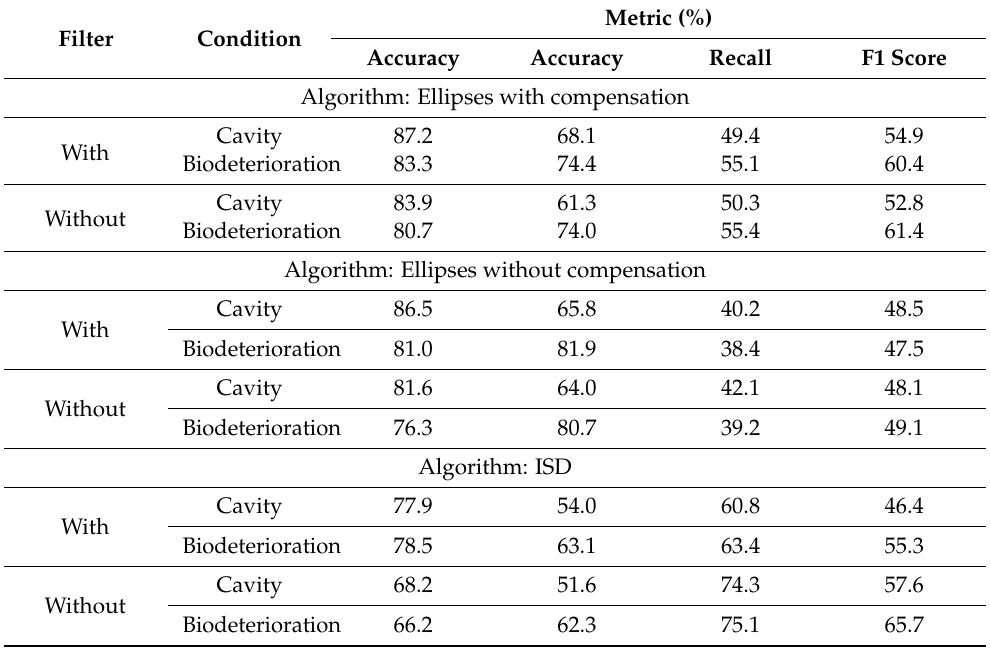
Table 6. Metrics obtained for the different algorithms and application or not of filter in the construc- tion of the images, adopting speeds up to 40% of the maximum speed for cavity inference and up to 45% of the maximum speed for cavity inference plus